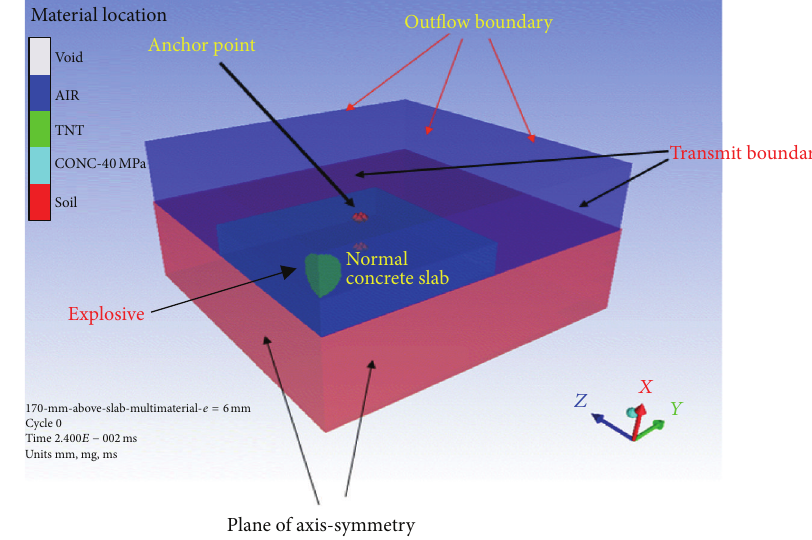
Figure 8: 3D numerical model of the normal concrete slab subjected to blast loading.